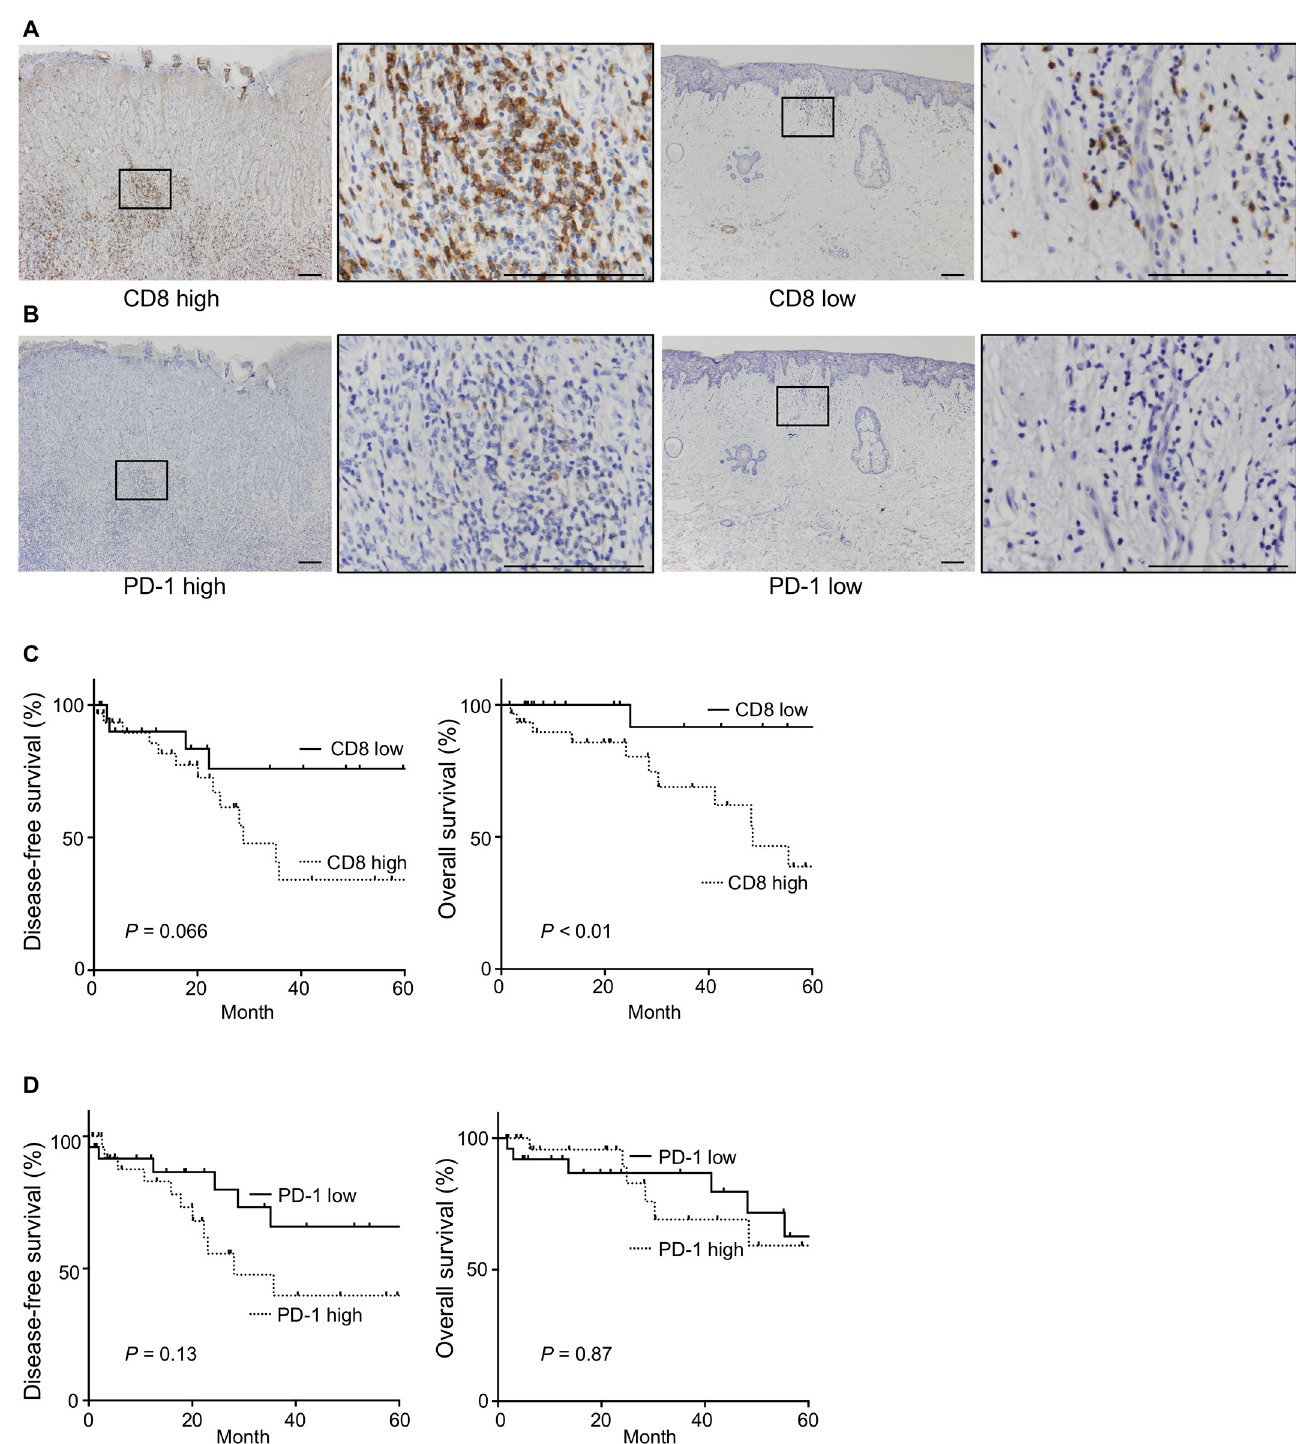
Fig 2. Immunohistochemical staining for CD8 and PD-1 in tumor specimens and Kaplan-Meier curves of DFS and OS stratified by the number CD8+ cells and PD-1+ cells. (A) Representative IHC stainings of tumor specimens with a high number of CD8+ cells and a low number of CD8+ cells are shown. (B) Representative IHC stainings of tumor specimens with a high number of PD-1+ cells and a low number of PD-1+ cells are shown. Scale bar, 100 μ m. (C) Kaplan- Meier DFS and OS curves stratified by the number of CD8+ cells adjacent to the tumor (n = 54) are shown. (D) Kaplan-Meier DFS and OS curves stratified by the number of PD-1+ cells adjacent to the tumor (n = 54) are shown. The log-rank test was performed for the univariate analysis.